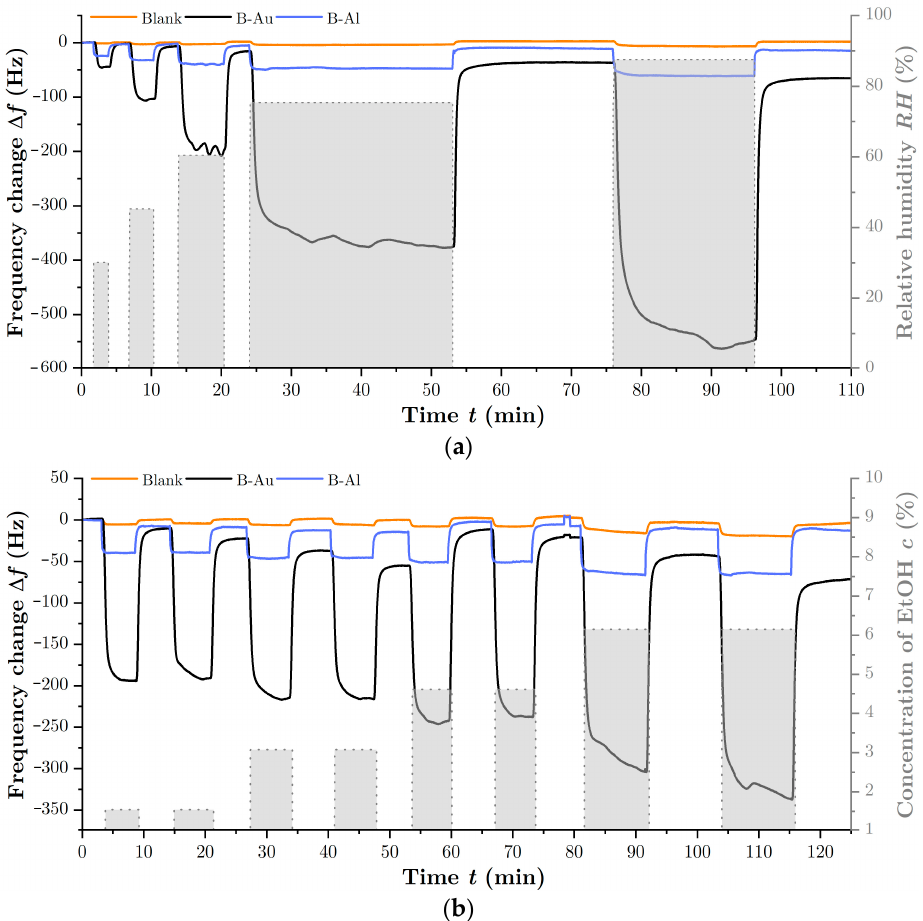
Figure 6. Response of QCM sensors with and without BMs coatings as a function of the concentration of H 2 O vapor in ( a ) and as a function of the concentration of EtOH vapor in ( b ). To determine the effect of the nanostructured black metal coating, the standard cali- bration curve was used, and the sensitivity, computed as a slope of the calibration curve (according to IUPAC), served as the main parameter [42]. Calibration curves for